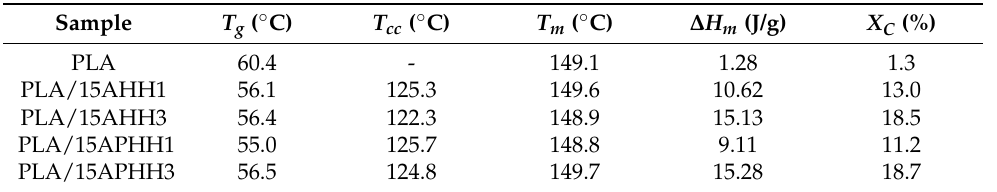
Table 5. DSC data corresponding to PLA and its